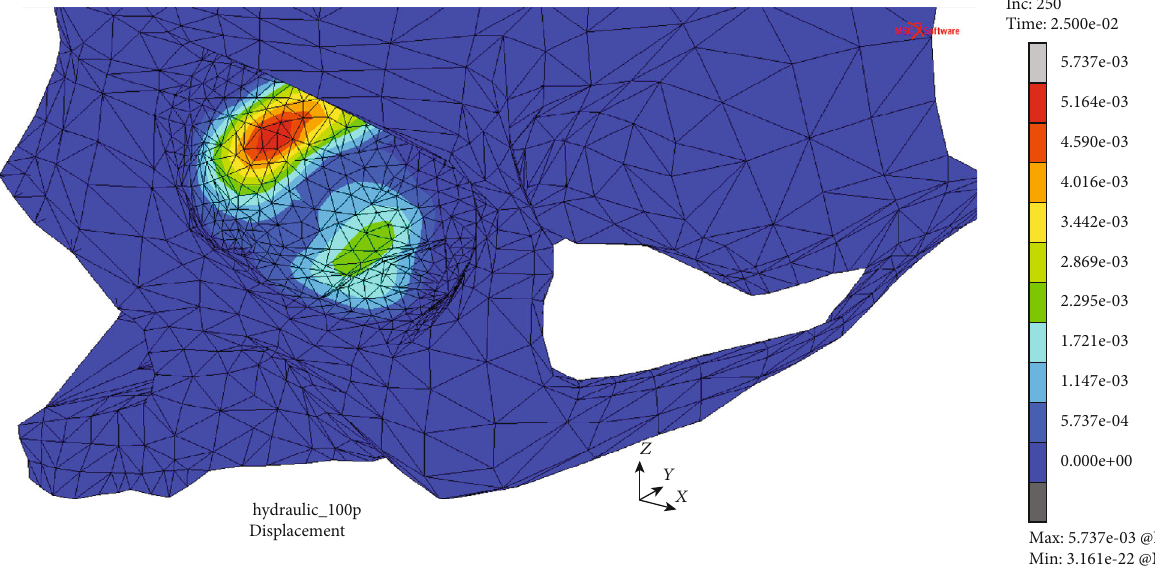
Figure 4: Displacement map (mm) without the deformation within the analyzed thin shell skull part during time t = 25 : 0ms